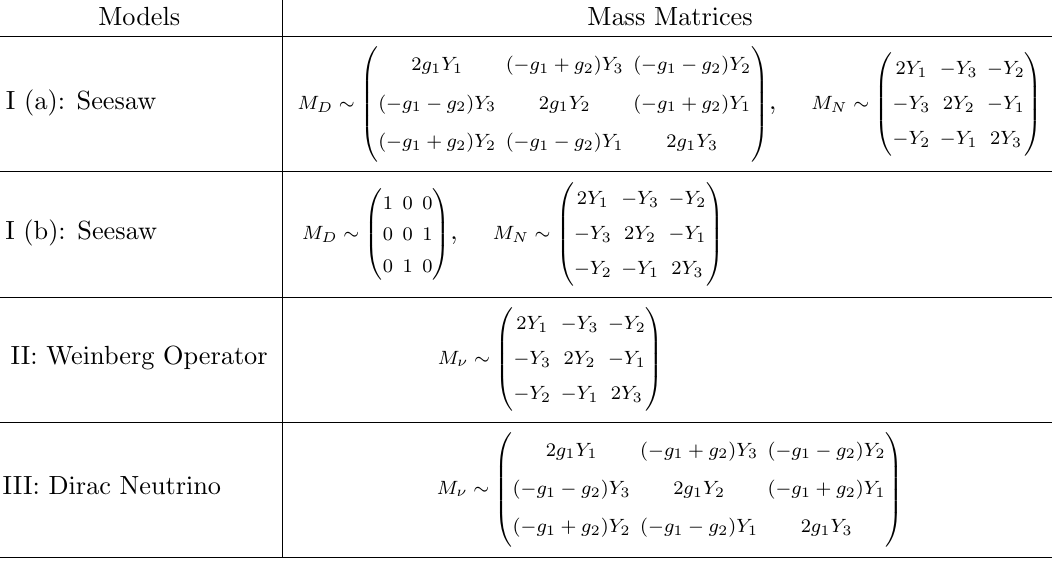
Table 2 . The classi(cid:12)cation of the modular invariant mass matrices for neutrino models. This matrix is the same one as in eq. (3.14) apart from the normalization because both left-handed neutrinos and the right-handed neutrinos are the triplet of A For the case where the neutrino is the Dirac particle, we use the mass matrix in eq.